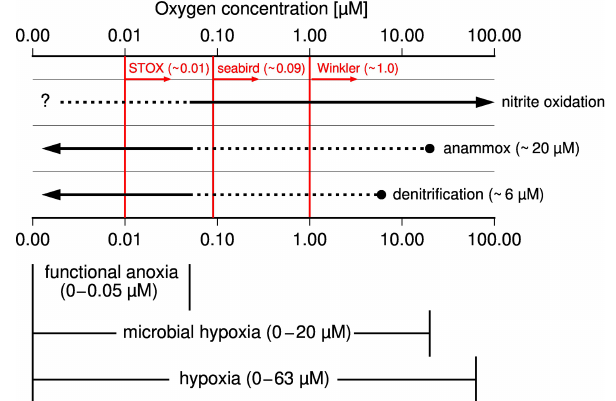
Figure 2. Schematic illustration showing the occurrence of micro- bial processes at varying oxygen levels, the subdivision of hypoxia into microbial hypoxia, and functional anoxia as well as detection limits of methods used to measure concentration of dissolved oxy- gen in seawater in red. Broken lines indicate processes which occur but do not control the fate of nitrite (reduction to N 2 versus oxida- tion to nitrate).